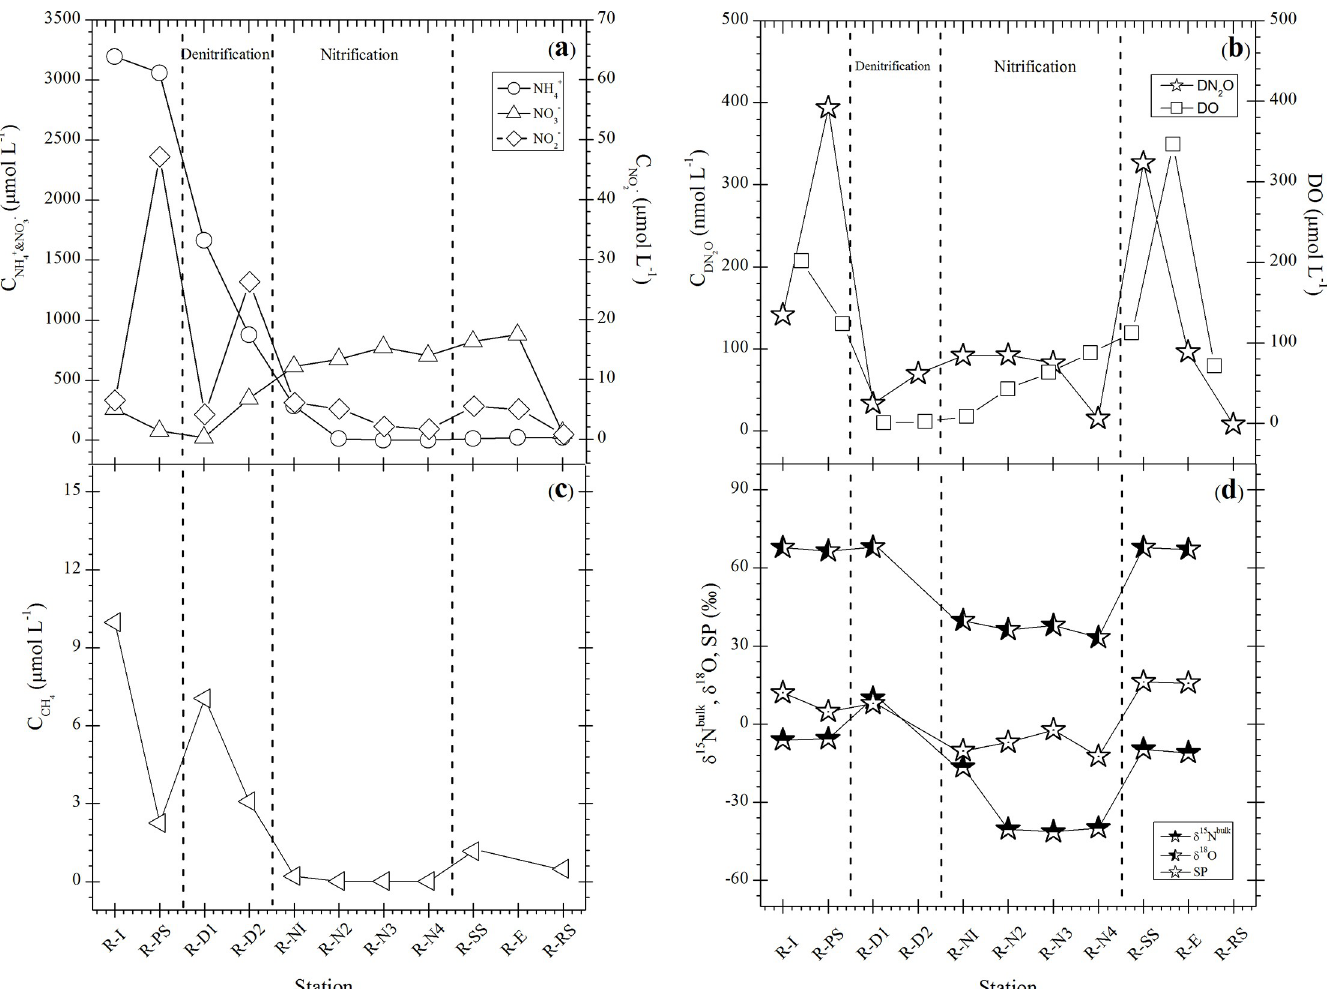
Fig 3. Concentration of dissolved inorganic nitrogen species (a) N 2 O, DO (b), CH 4 (c) and isotope/isotopocule ratios (d) of N 2 O at each station in the MLE system at